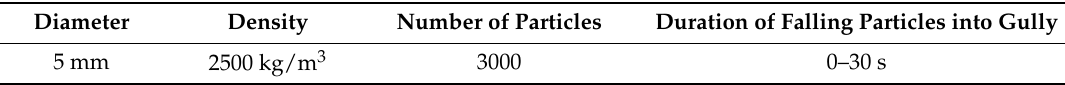
Table 2. Properties of the solid particles for Computational Fluid Dynamics (CFD)